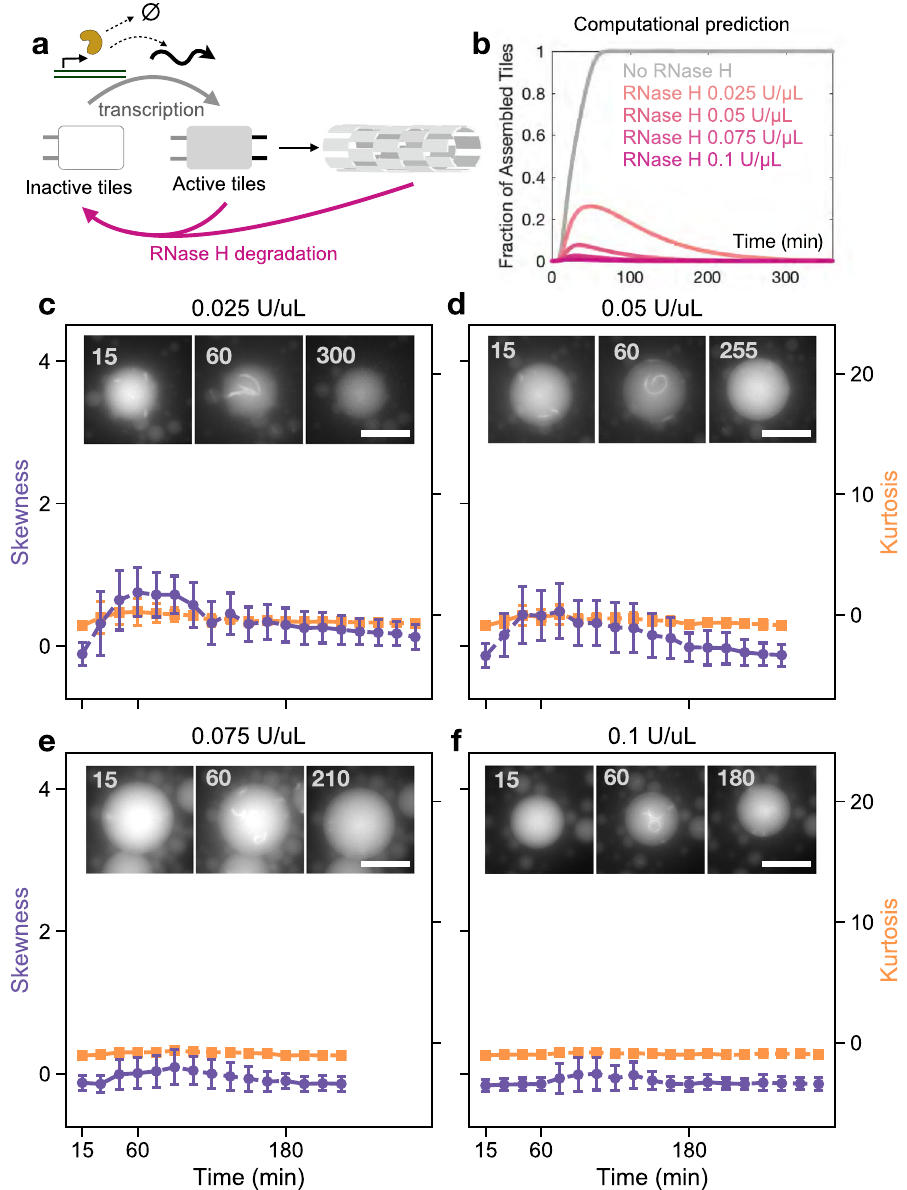
Fig. 6 Enzyme-mediated control of assembly and disassembly of encapsulated hybrid DNA-RNA tubes at 37 °C. a Schematic of the reactions occurring in a sample that includes inactive tiles, DNA template transcribing the RNA trigger (promoting growth of nanotubes), and RNase H (promoting degradation of nanotubes). b Computational prediction showing that loss of activity of RNAP against unchanged RNase H activity yields a temporal pulse in the fraction of assembled tiles, whose peak and duration depend on the amount of RNase H. Increasing amounts of RNase H are represented with darker shades of pink. Modeling details are in Supplementary Note S6.3. c – f Representative fl uorescence microscopy images of the RNase H titration experiments (insets) with plots of mean skewness (purple) and kurtosis (orange) for sampled droplets. Inactive tiles at 500 nM concentration were encapsulated with 100 nM gene template, 2.5% w/v PEG, 2.5% v/v RNAP, and 0.025 U/ µ L – 0.1 U/ µ L RNase H. These experimental results show that, when RNA trigger transcription and degradation components are simultaneously present, a pulse of nanotube polymerization is observed. Eventually RNase H causes disassembly of the nanotubes at a speed that depends on the RNase H concentration, presumably due to a decrease of RNAP activity. Skewness and kurtosis are plotted in shades of purple and orange, respectively. Data were presented as mean values ± standard deviation. Data extracted using droplet detection code as described in Supplementary Note S4.13. The number of droplets sampled and histograms of radii for sampled droplets are in Supplementary Notes S5.9 and S5.10. (Also see: Supplementary Movie 4). Source data for this fi gure is provided as a source data fi le. Scale bars: 20 μ